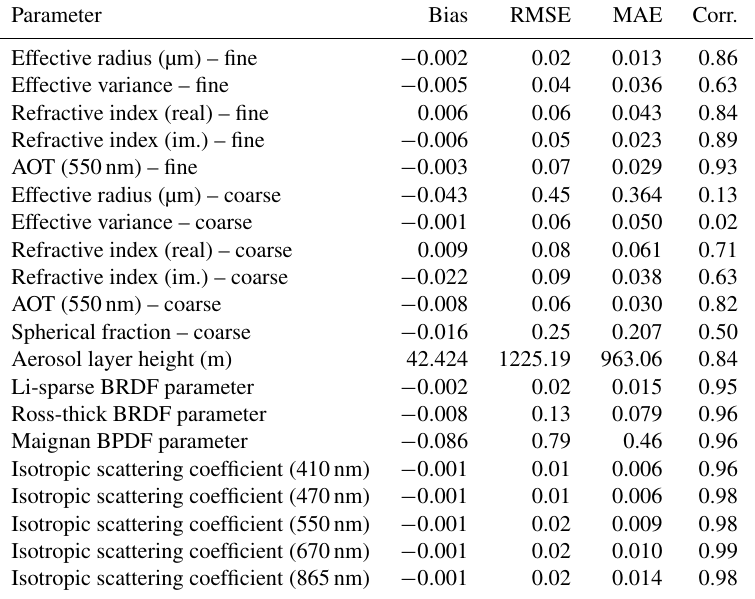
Table 2. Error statistics on the aerosol and surface parameters retrieved by the neural network, computed on a set of data not used during the training phase.